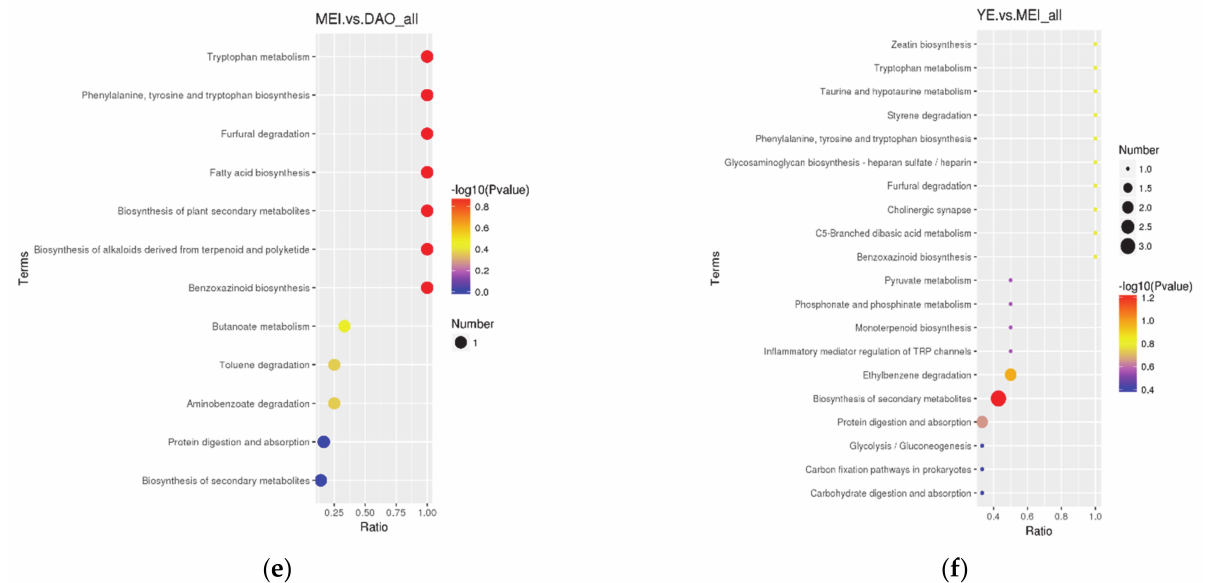
Figure 2. The VOC metabolic variation in aromatic rice varieties. ( a ) PLS-DA scores plot of Meixiangzhan 2 vs. Dao- huaxiang 2. ( b ) PLS-DA scores plot of Yexiangyoulisi vs. Meixiangzhan 2. ( c ) PLS-DA scores plot of Yexiangyoulisi